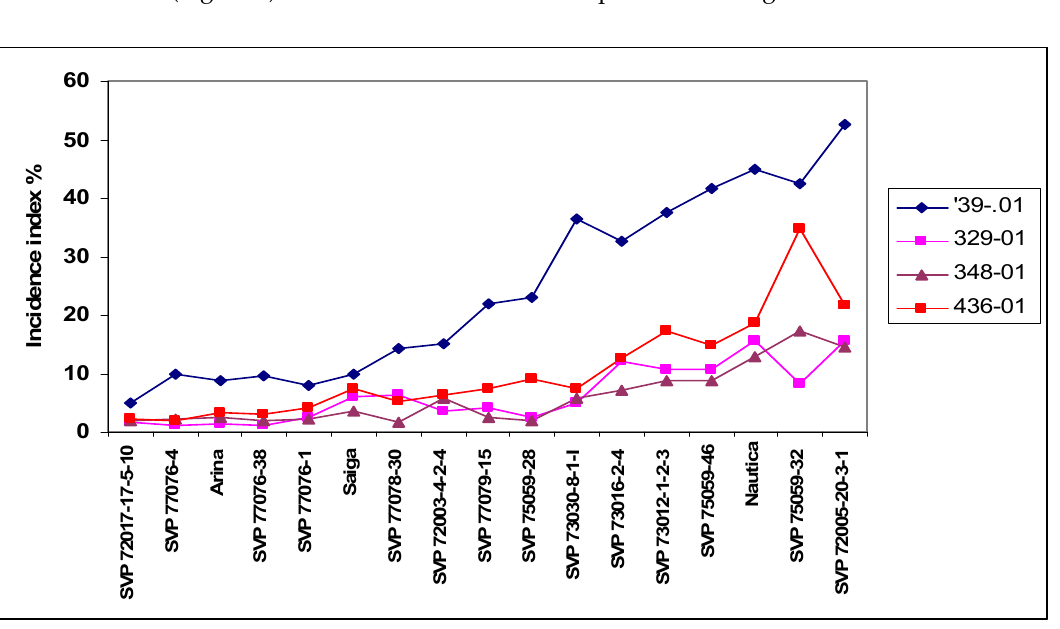
Fg: F. graminearum , Fc: F. culmorum